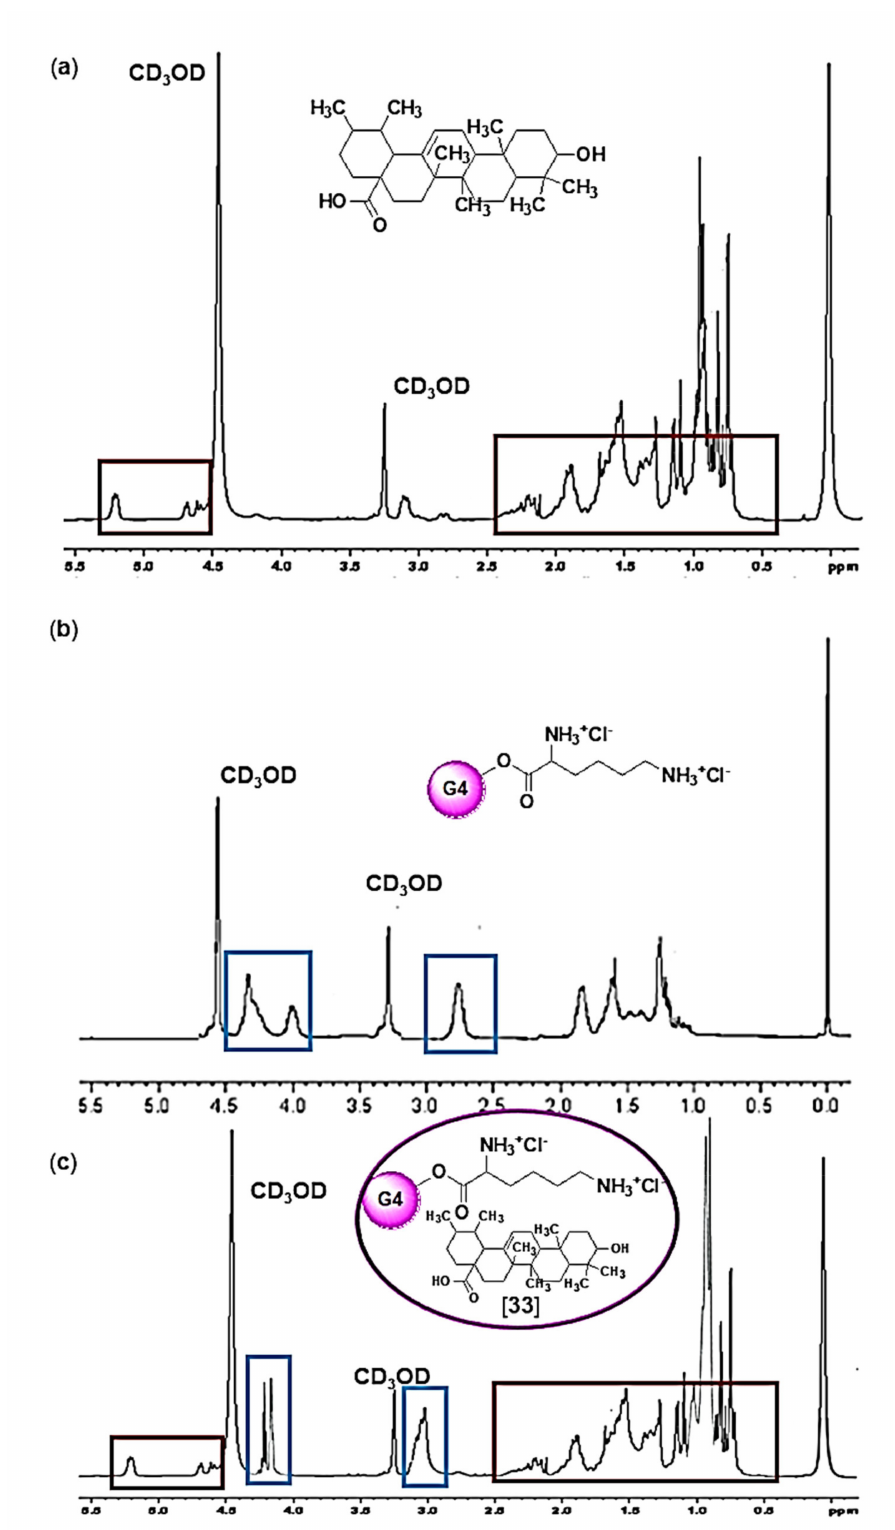
Figure 5. 1 H nuclear magnetic resonance (NMR) spectra (CD 3 OD, 400 MHz) of UA ( a ), G4K ( b ) and of UA-G4K ( c